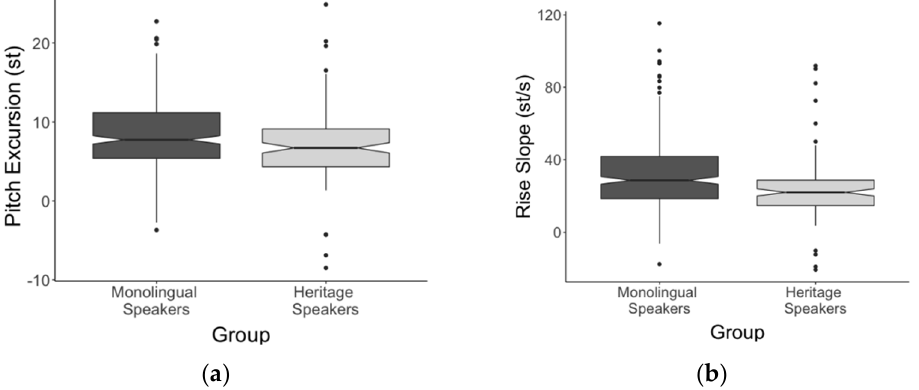
Figure 2. ( a ) Pitch excursion (st) of uptalks by group; ( b ) Rise slope of uptalks (st/s) by group.